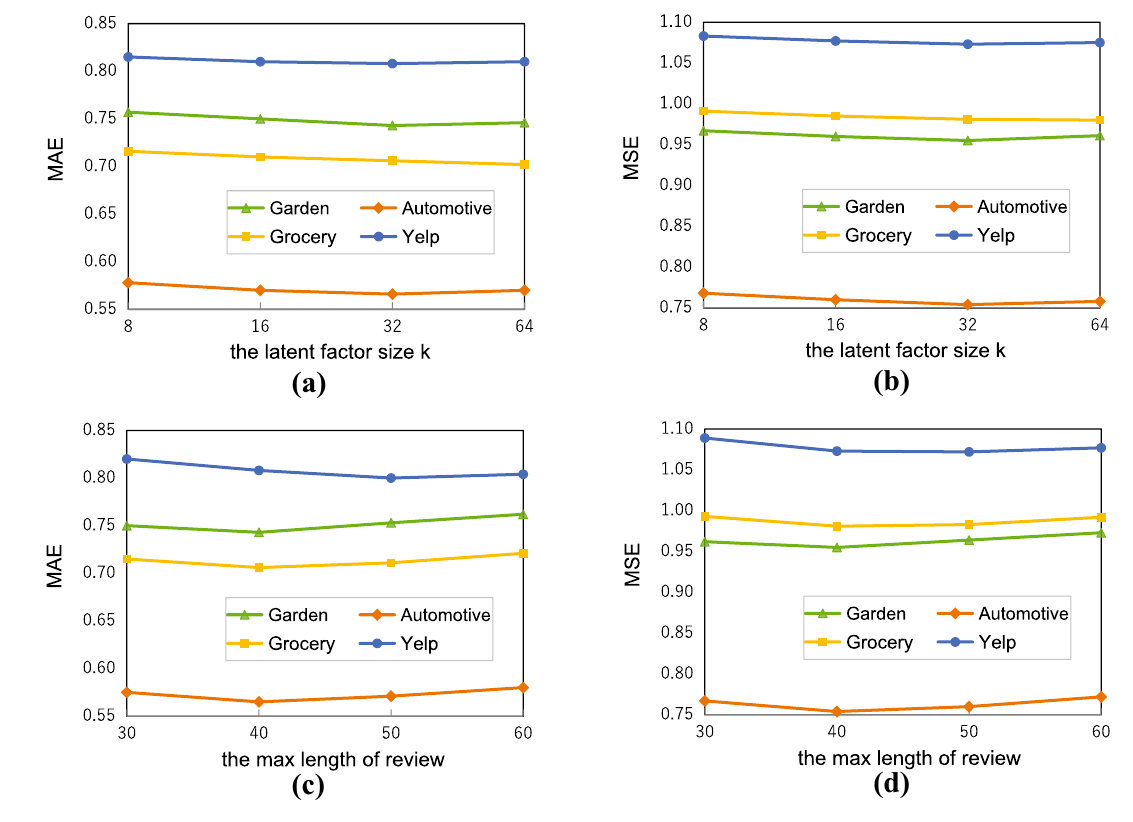
Fig. 2 Performance of different size of latent factor and max length of